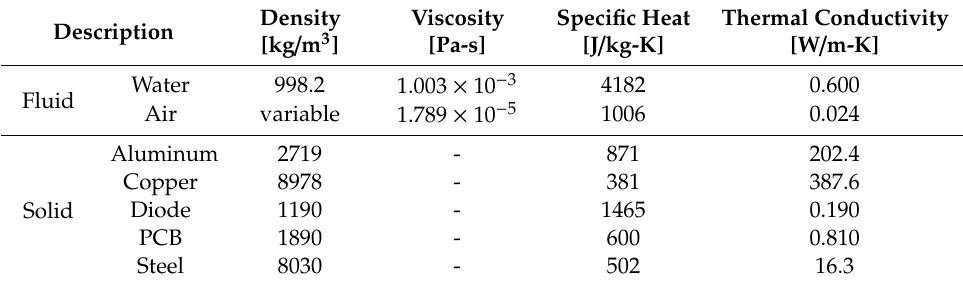
Table 1. Physical properties of the components and materials in the integrated